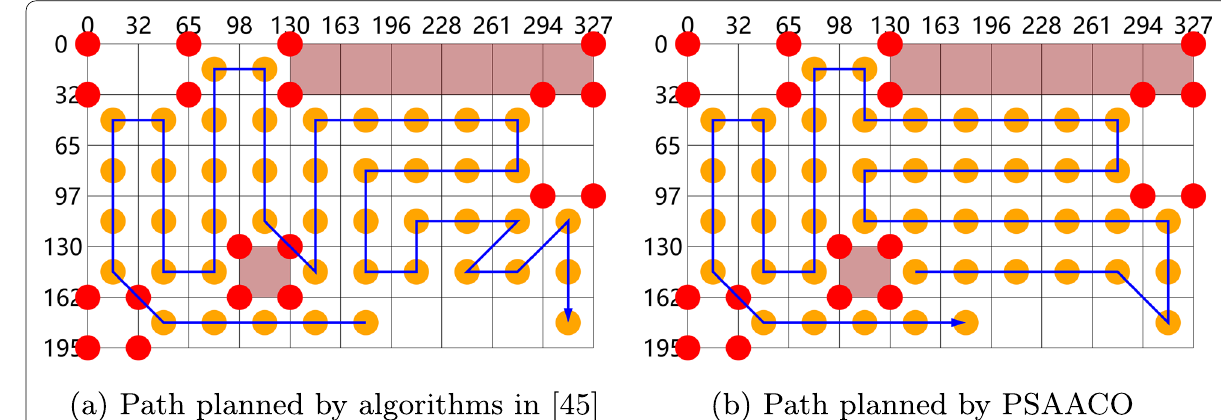
Fig. 9 Paths planned by the algorithms in [45] and